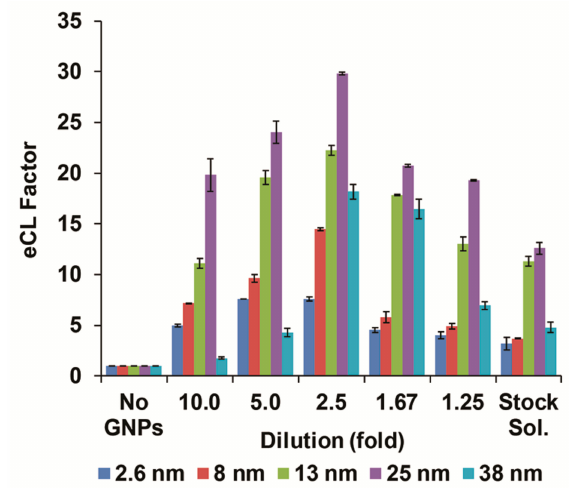
Figure 3. Enhanced CL factor of the di ff erent cross-linked GNPs dilutions for the various nanoparticle sizes within the luminol system. The enhancement values were calculated with respect to CL values in the absence of cross-linked GNPs. Data are reported as mean ± standard deviation ( n ≥